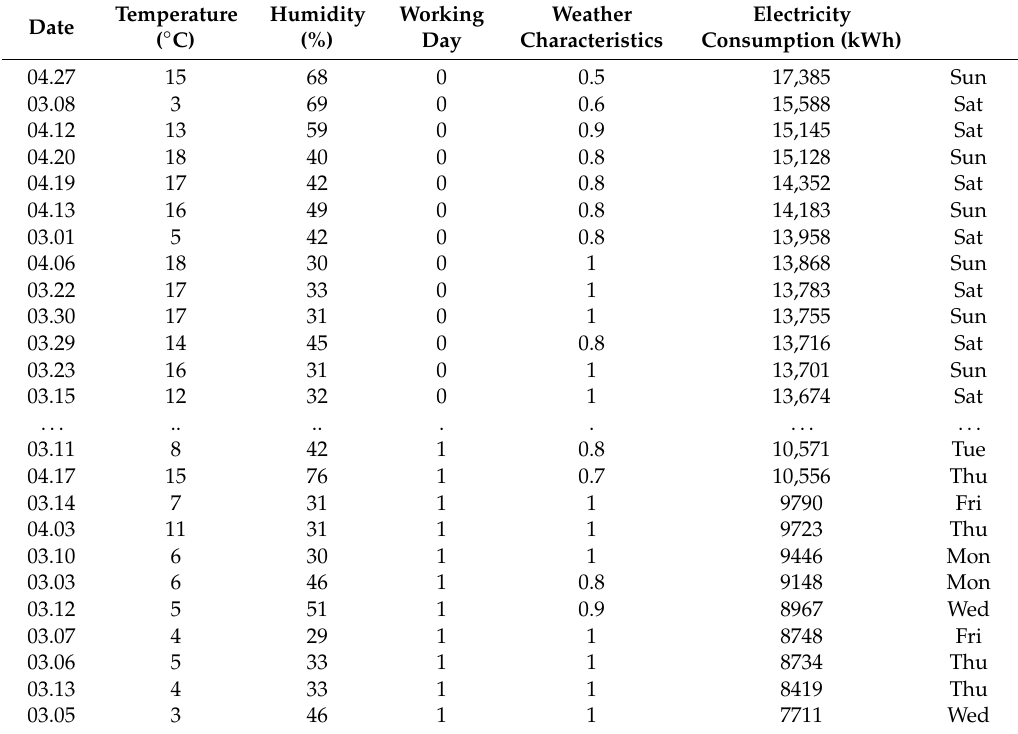
Table A1. Electricity consumption data for a shopping mall in Dalian